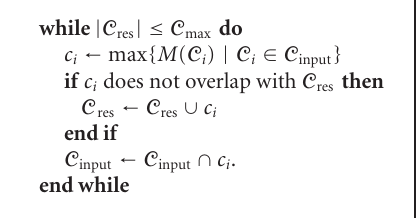
Algorithm 2: Best candidate